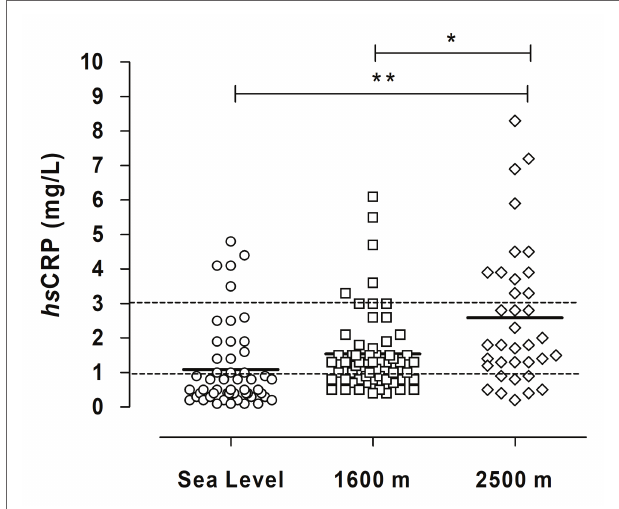
FIGURE 1 | Plasma concentration of hs CRP in miners exposed to CIHH at several altitudes. The horizontal thick line represents a mean value of hs CRP at each altitude. The horizontal dotted line represents a cut-off of cardiovascular risk (<1 mg/L, low; >1 and <3, moderate; and >3 high). Asterisks represent a significant difference between sea level and 2,500 m ( p < 0.05) and double asterisks represent a significant difference between 1,600 and 2,500 m ( p < 0.05).